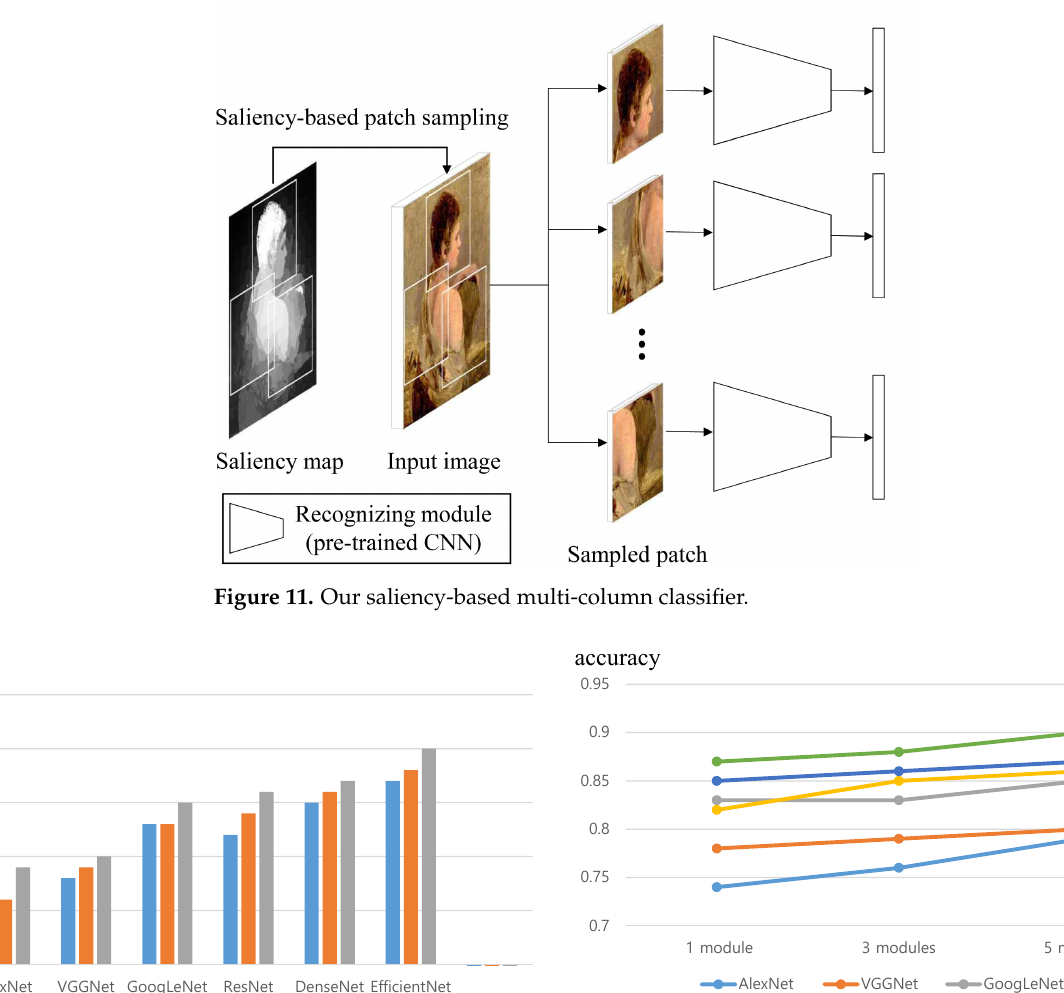
(b) Comparison of CNN models per the number of modules(a) Comparison of the number of modules per CNN